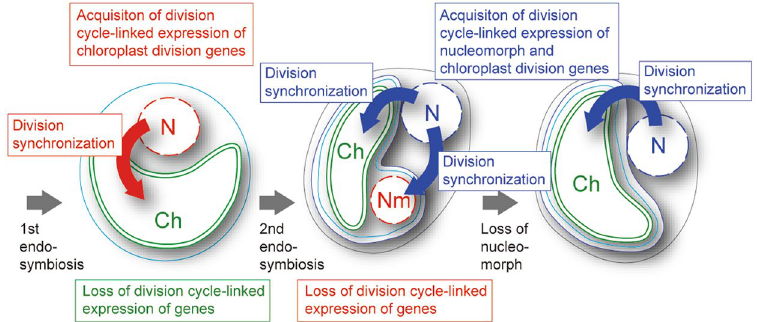
Figure 6. Schematic diagram of the evolution of the regulation of nucleomorph and chloroplast division by the host cell. “N”, “Nm” and “Chl” indicate nucleus, nucleomorph and chloroplast, respectively. Red and blue arrows indicate chloroplast division or nucleomorph-replication proteins that are encoded in the genome of the primary algal nucleus and the secondary algal nucleus,